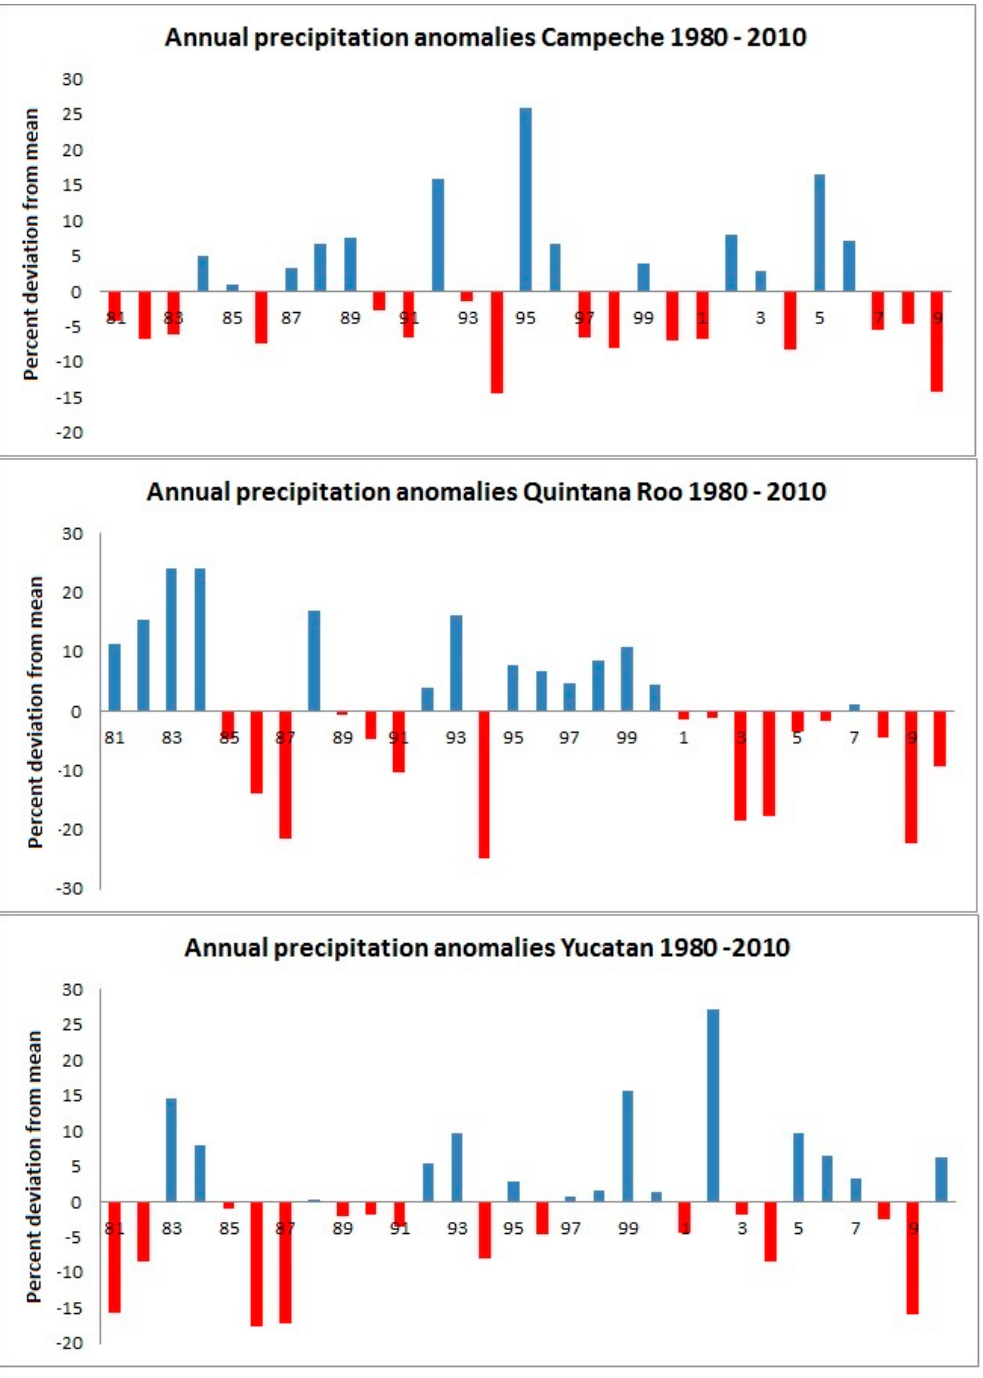
Figure 4. Annual precipitation anomalies for the three states, 1981–2010.